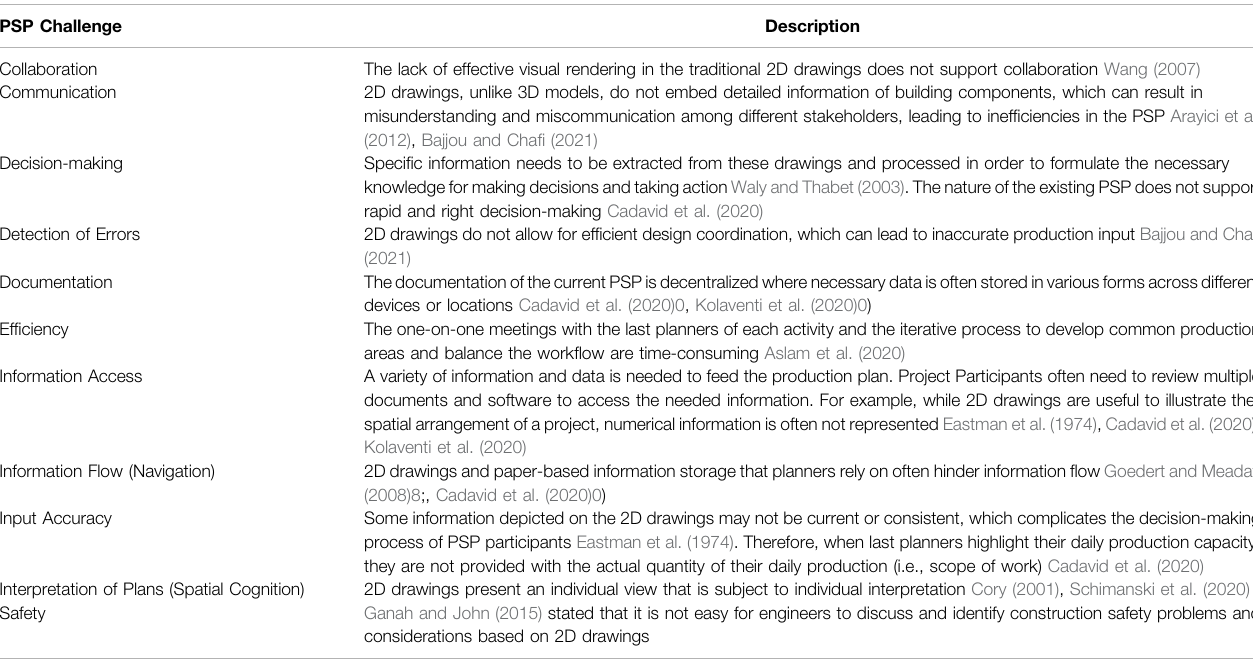
TABLE 2 | Challenges associated with the Current State